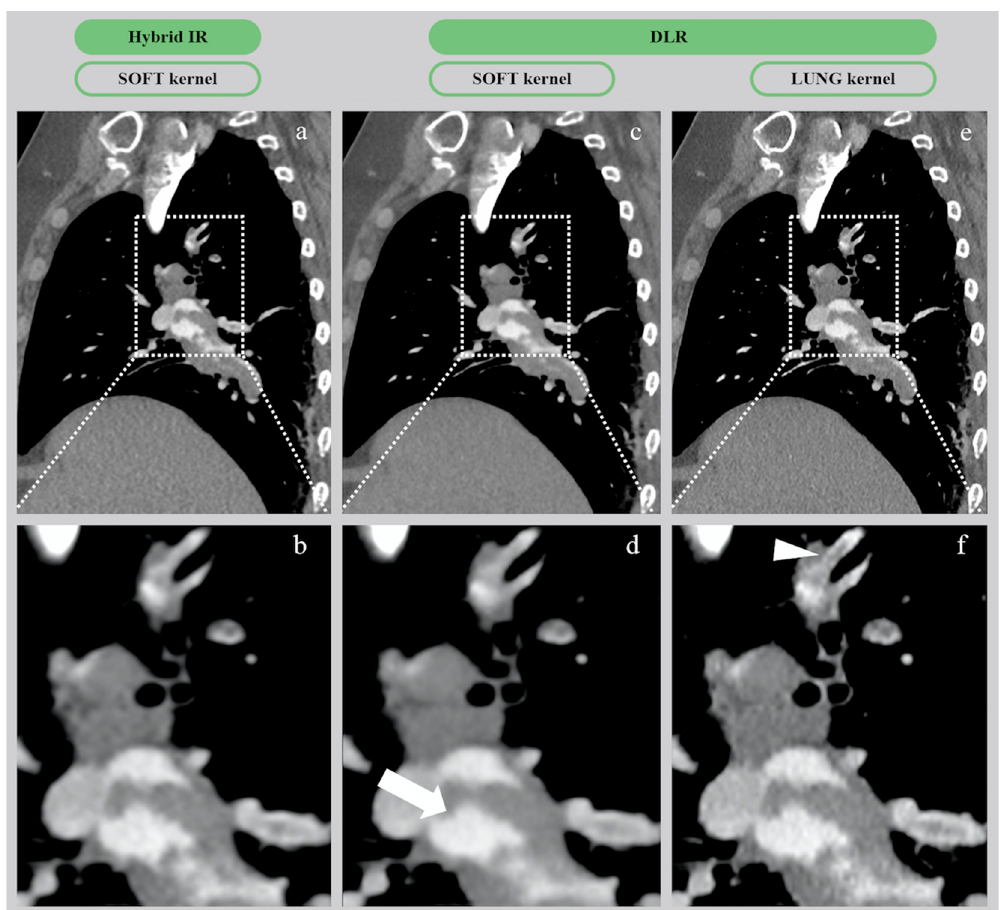
Figure 6. CTA images of pulmonary embolism in a 54-year-old woman (BMI = 42.5 kg/m 2 ) with hybrid-IR (AIDR 3D) and DLR (AiCE) reconstructions. ( a , b ) Native and zoomed CT images from hybrid-IR (AIDR 3D) with 1 mm-thick slices on soft filter. ( c , d ) Native and zoomed CT images from DLR (AiCE) with 0.5 mm-thick slices on soft filter. ( e , f ) Native and zoomed CT images from DLR (AiCE) with 0.5 mm-thick slices on lung filter. On the zoom-in images, the DLR soft image appears as a virtually noise-free image (white arrow), whereas the DLR lung image provides the best spatial resolution, with excellent SNR/CNR depicting a clear subsegmental thrombus (white arrowhead). CTA, computed tomography angiography; Hybrid-IR, hybrid iterative reconstruction (AIDR 3D, adaptive iterative dose reduction 3-dimensional); DLR, deep learning reconstruction (AiCE, advanced intelligent clear-IQ engine); BMI, body mass index; CNR, contrast-to-noise ratio.